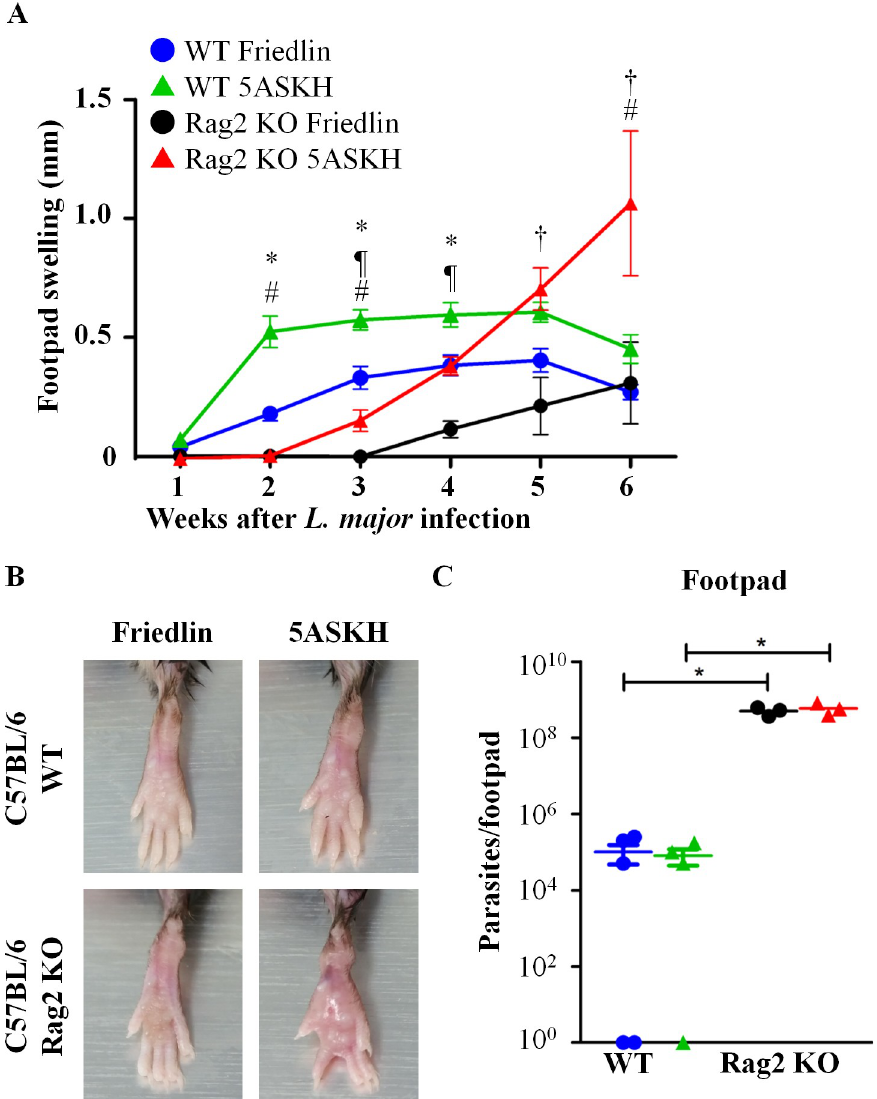
Fig 2. Parasite strain-dependent influence of T/B lymphocytes on pathogenesis in resistant C57BL/6 mice. C57BL/ 6 WT and Rag2 KO mice were infected with 5 × 10 6 stationary phase promastigotes of L . major Friedlin or 5ASKH subcutaneously into the hind footpad. (A) Footpad swelling after L . major infection. All the data are from normal distribution except data of C57BL/6 mice at 1 week post-infection of L . major Friedlin have deviated from normal distribution. Data deviated from normal distribution were excluded from statistical comparison. Symbols: WT mice infected with L . major Friedlin blue circle or 5ASKH green triangle, Rag2 KO mice infected with L . major Friedlin black circle or 5ASKH red triangle; 3–10 mice per group. (B) Representative photographs of a L . major -infected footpad at 6 weeks post-infection. (C) Parasite burden at 6 weeks post-infection. Each mouse footpad was homogenized in 10 ml culture media and cultured for 3 days then viable promastigotes were counted microscopically. Three–five mice per group. Data are the mean ± SEM. Results are representative of two independent experiments with similar outcomes. � †¶# means P < 0.05 between WT-Friedlin × WT-5ASKH: � ; Rag2KO-Friedlin × Rag2KO-5ASKH: †; WT-Friedlin × Rag2KO-Friedlin: ¶ and WT-5ASKH × Rag2KO-5ASKH: #. different species of Leishmania . Further immunological analyses are needed to inquire into the differential lymphocyte response towards different Leishmania strains and species.